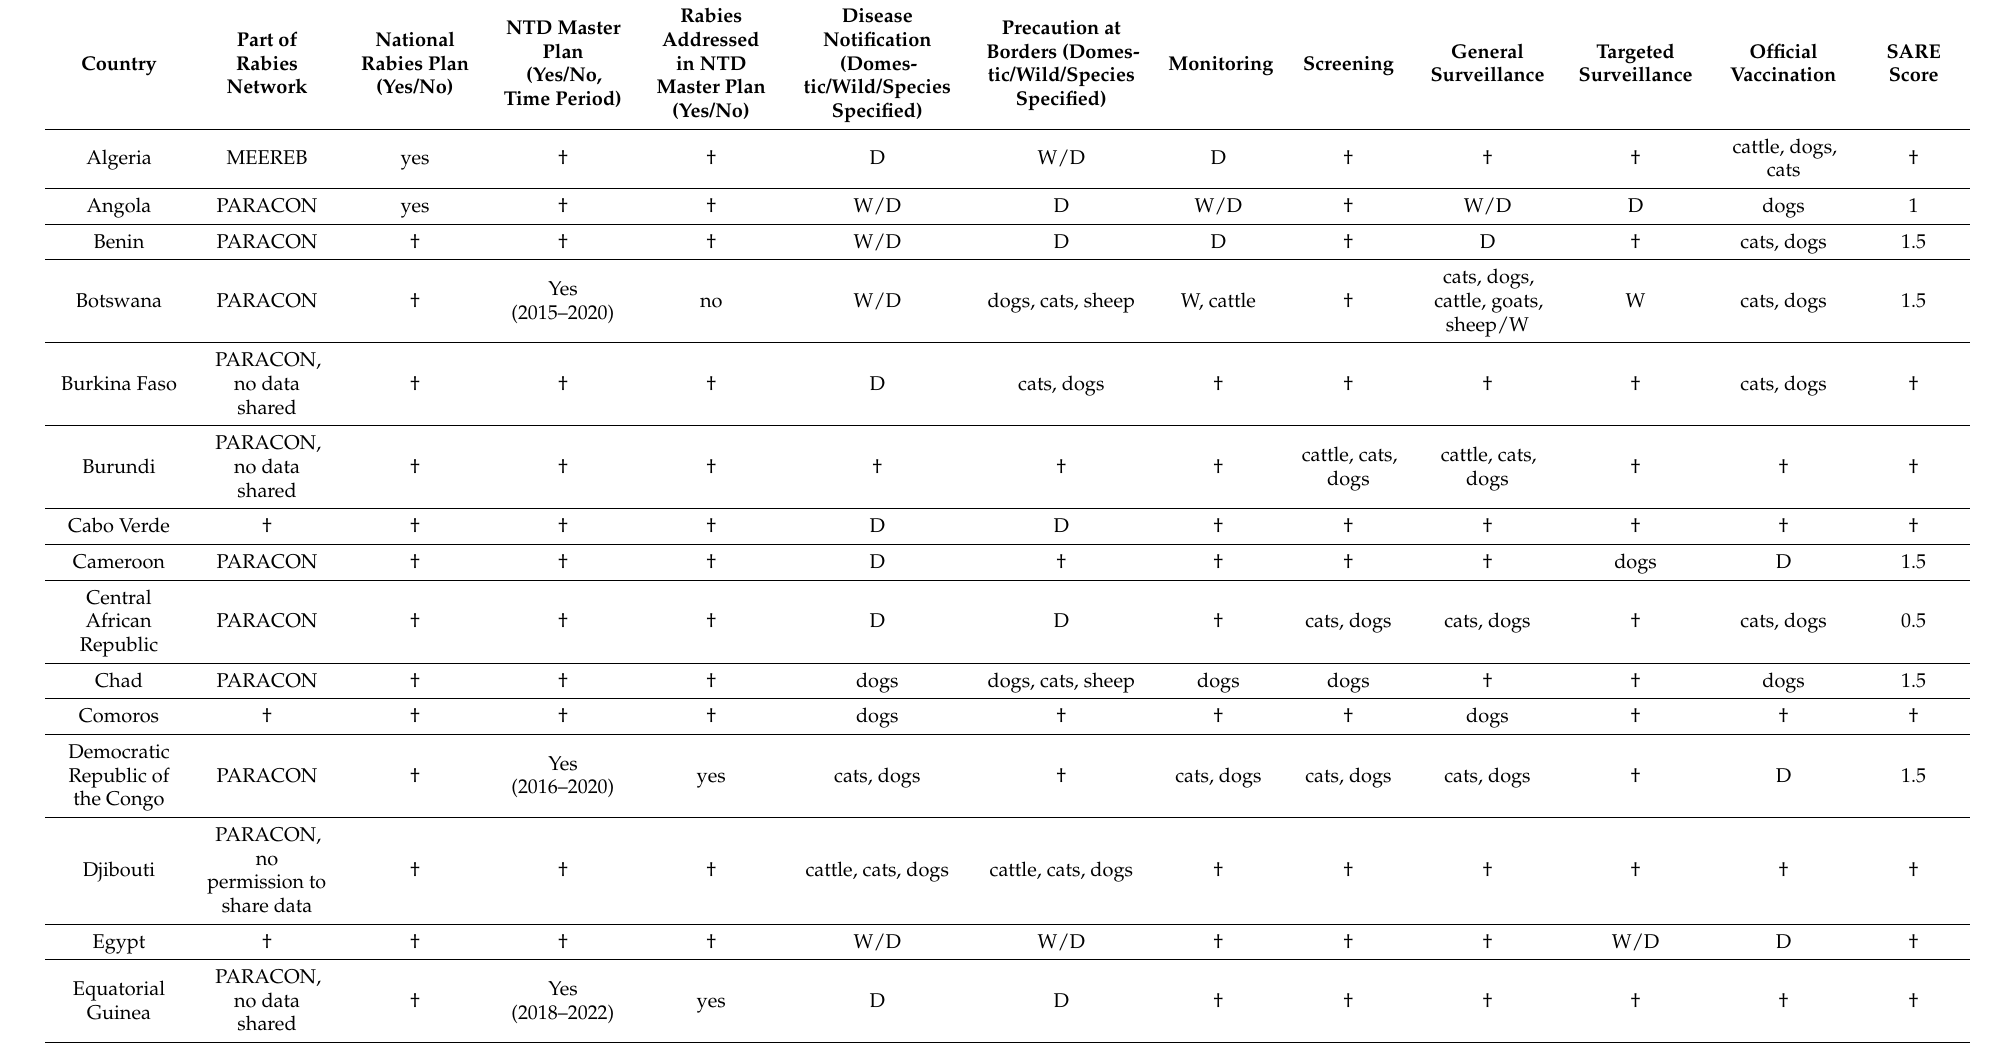
Table 1. Summary of extracted key variables for 54 African